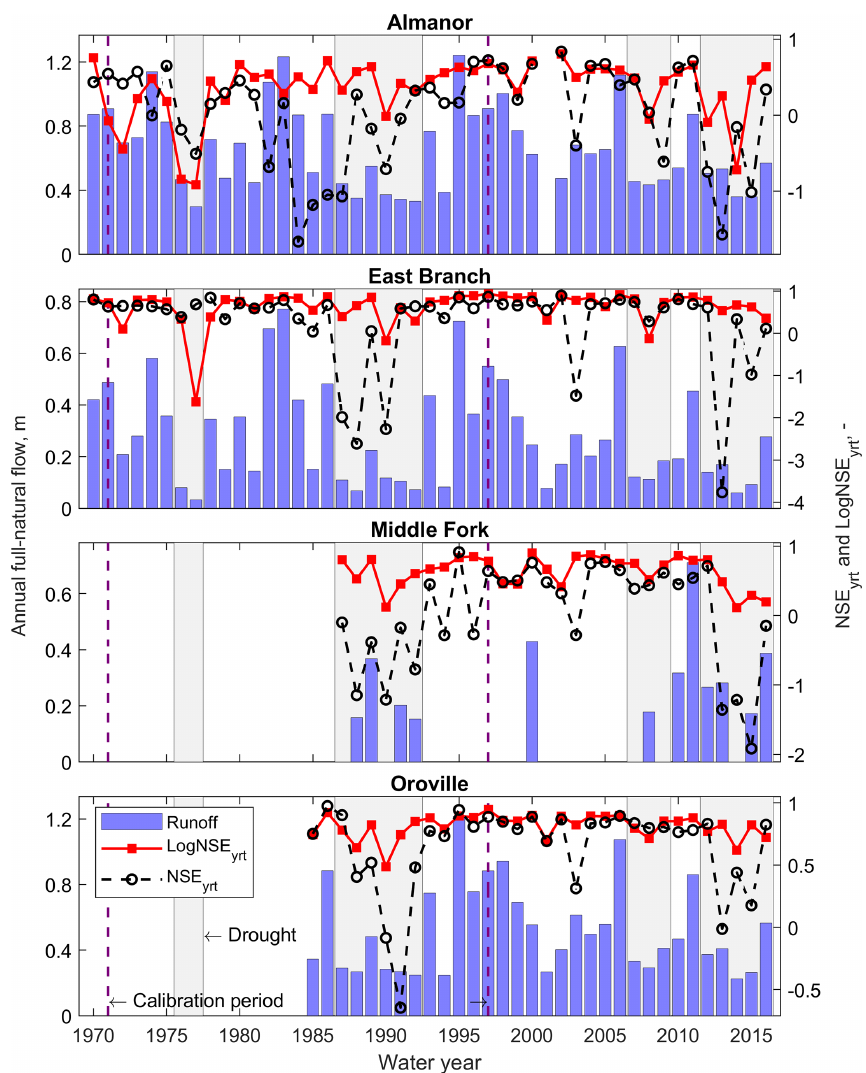
Figure 5. Water-year Nash–Sutcliffe efficiency (NSE yrt ) and Log-Nash–Sutcliffe efficiency (LogNSE yrt ) for PRMS-modeled daily full- natural flow. The blue bars represent observed annual full-natural flow at the outlet of each (sub-)basin.